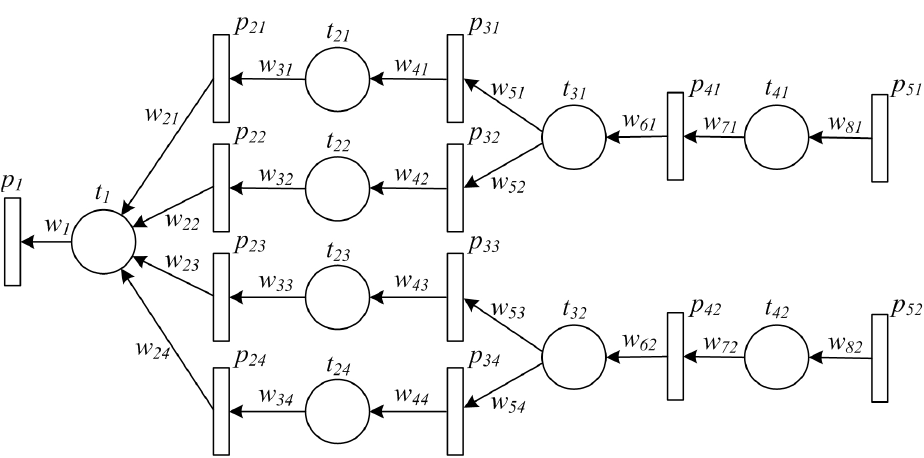
Figure 7. An example of TPN model for a typical manufacturing